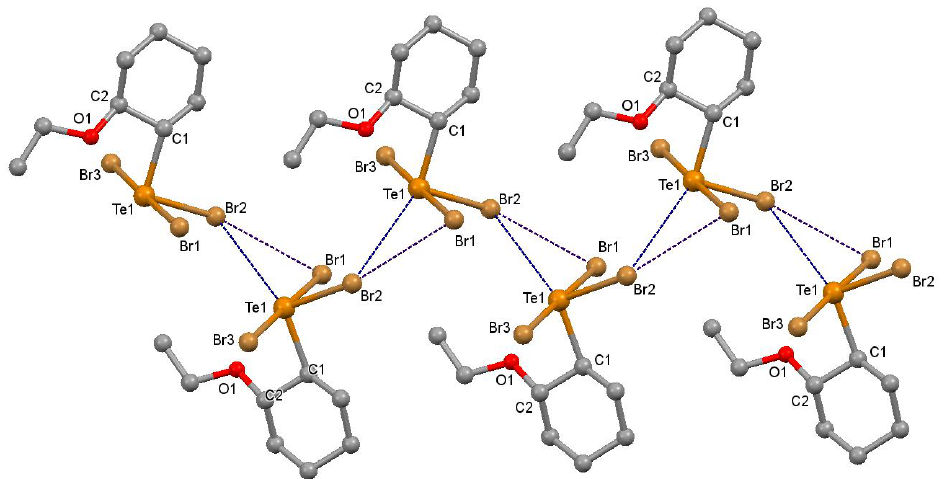
Figure 3. Fragment of packing in the crystal of 6 ( P 2 1 / n ) showing the Te---I ChB and Br---Br XBs stabilized catemer chain. Hydrogen atoms are omitted for clarity. Selected distances ( Ǻ ): (intramolecular) Te1-Br1 2.6749(4), Te1-Br3 2.6271(4), Te1-Br2 2.4800(5), Te1-O1 2.716(2); (intermolecular); Te1-Br2 3.9027(5), Br2-Br1 3.5956(5).